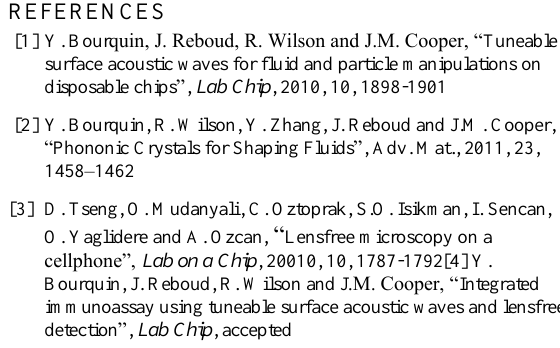
A dose-response curve for interferon-γ, is presented in Figure 1b. The limit of detection was situated around 1 pM, which is the limit required for the diagnostic of tuberculosis in the interferon-γ release assay and the dynamical range spanned three order of magnitude (1- 1000 pM). The use of SAW streaming enhanced the beads